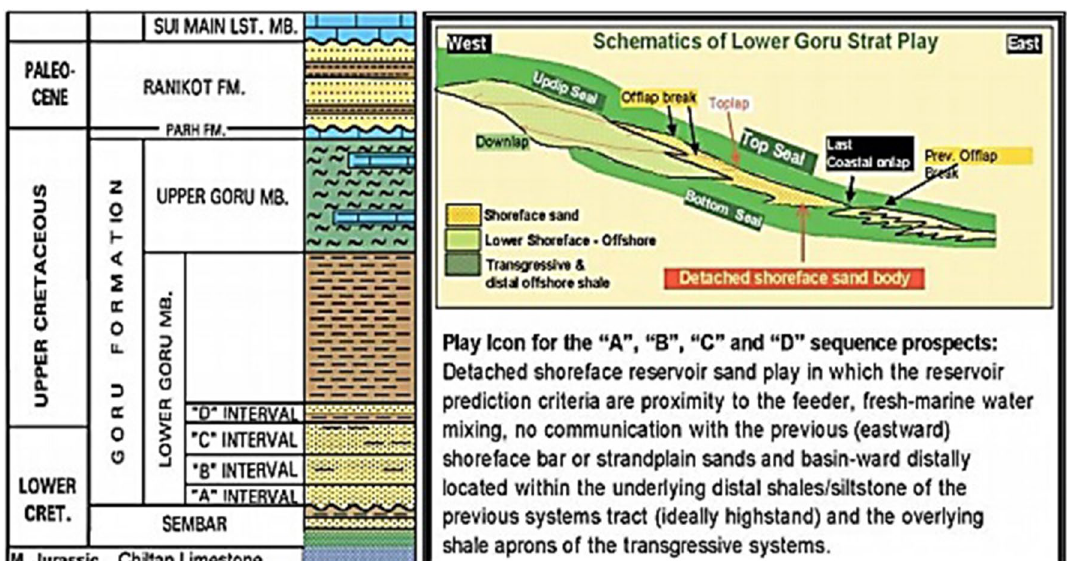
Fig. 2 Stratigraphic distribution of Goru Formation (Ahmad et al. 2004) Fig. 3 Classification of lower Goru sandstone (C-interval) (Berger et al.